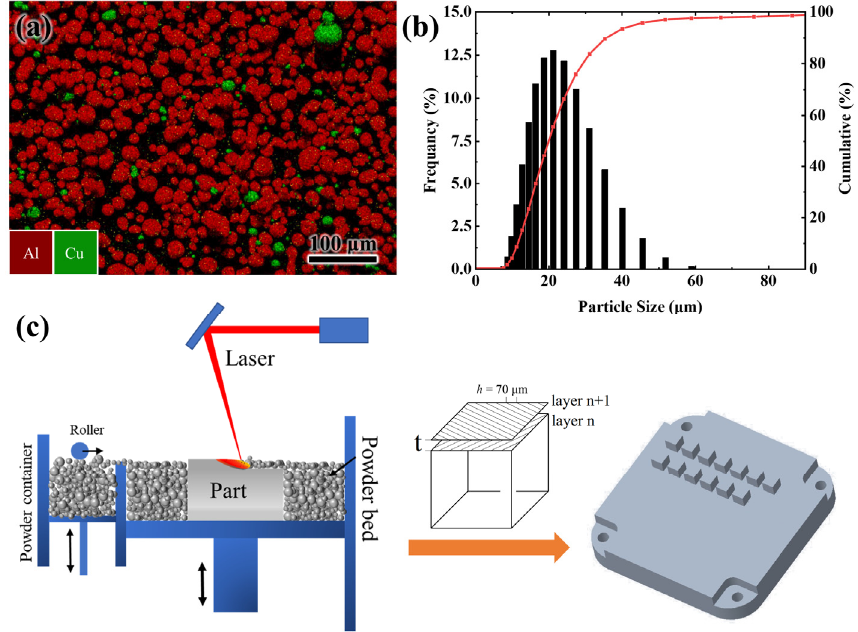
Figure 1. ( a ) Al powder and Cu powder distribution and ( b ) particle size distribution of blended Al20Cu powder. ( c ) Schematic of LPBF process and scanning strategy. Table 1. Processing parameters used in the sample printing